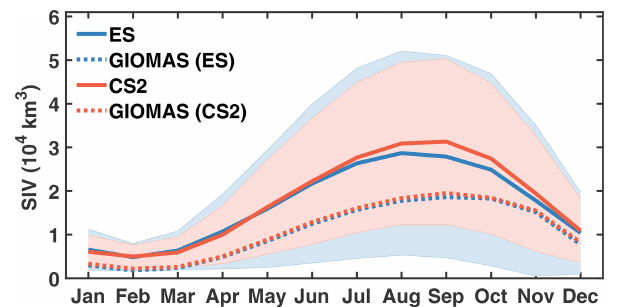
Figure 3. The climatological annual cycle of Antarctic SIV. The blue and red denote data related to ES and CS2, respectively. The solid and dashed curves denote satellite observations and corre- sponding GIOMAS data. The shaded areas denote the uncertainty of satellite SIV.